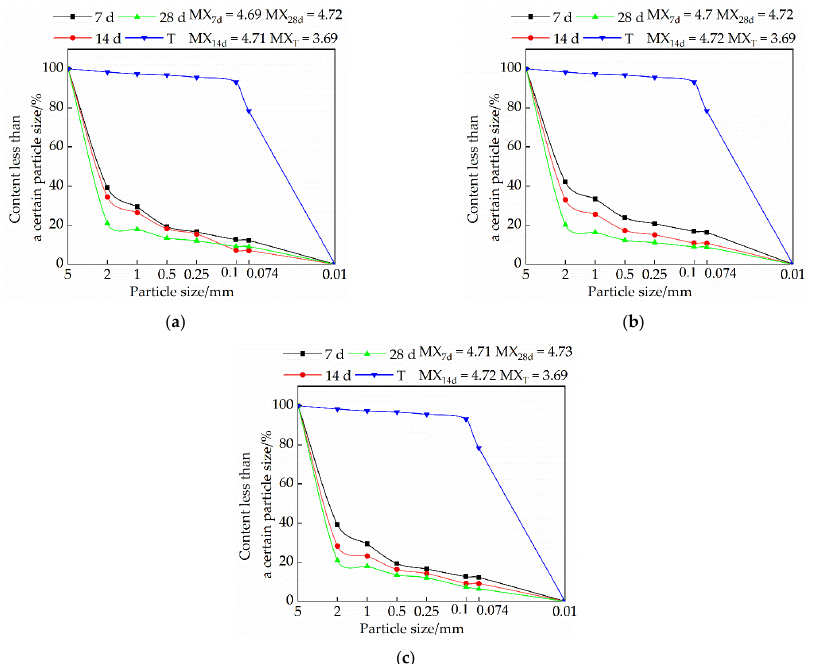
Figure 8. Influence of sodium methyl silicate on sample particle size distribution: ( a ) particle size distribution of samples in group J1; ( b ) particle size distribution of samples in group J2; ( c ) particle size distribution of samples in group J3 .